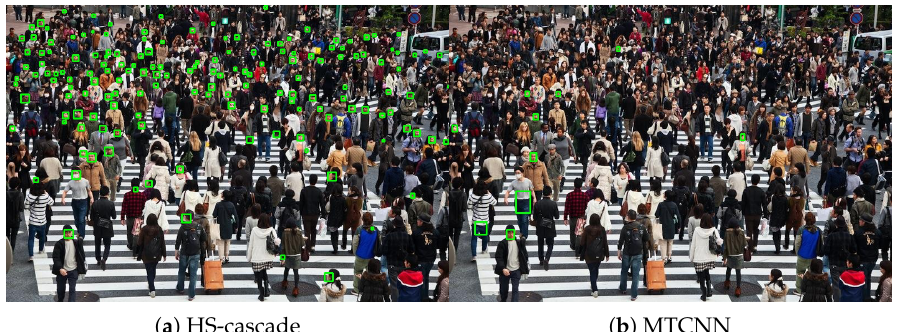
Figure 14. Comparison between HS-cascade and MTCNN (Example